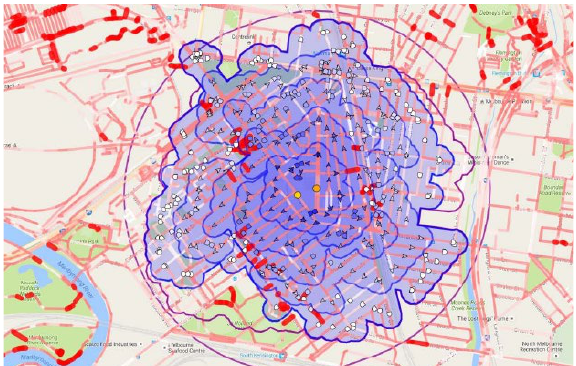
Figure 1 : Screen grab of pedestriancatch.com tool used to analyse access to Kensington Primary